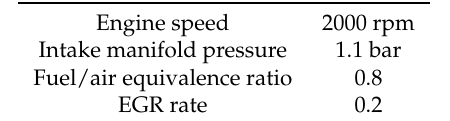
Figure 3. Stationary measurements of the center of combustion COC for four distinct values of DOI , where the start of injection SOI is varied. Table 2. Operating point used for the system